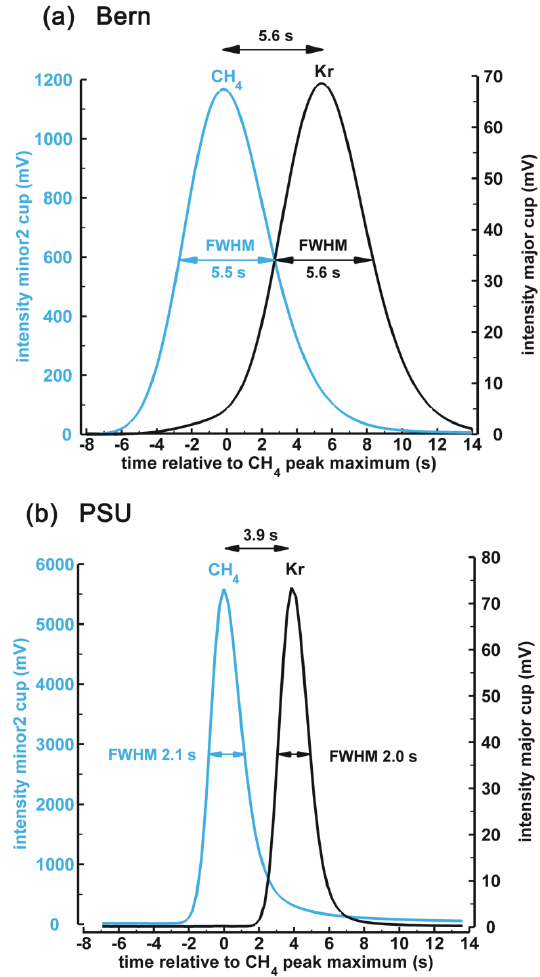
Fig. 3. Chromatogram of an atmospheric air sample showing the separation of CH 4 from Kr for the Bern system (a) and the PSU system (b) . The ion source of the IRMS was focused such that the m/z 43 beam of 86 Kr 2 + falls into the major cup (black line, right axis). The isotopologues of CO 2 with m/z 45 fall into the minor2 cup and mark the position of the CH 4 peak (blue line, left axis).